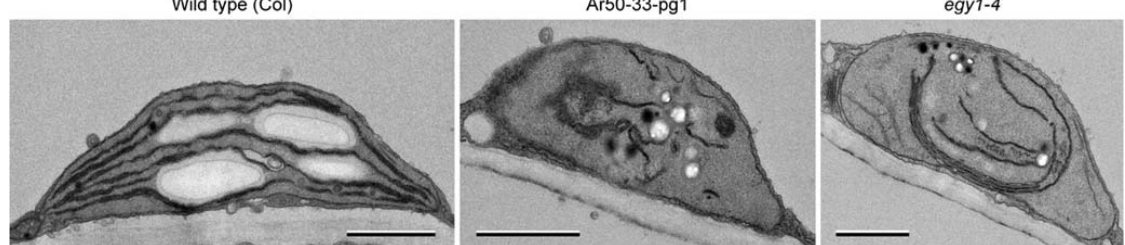
Figure 9. TEM analysis of pavement cells in the fully expanded leaves of wild-type and mutant plants. Primary leaves of 3-week-old wild-type (Col), Ar50-33-pg1, and egy1-4 plants were analyzed. Bar = 1 µm.